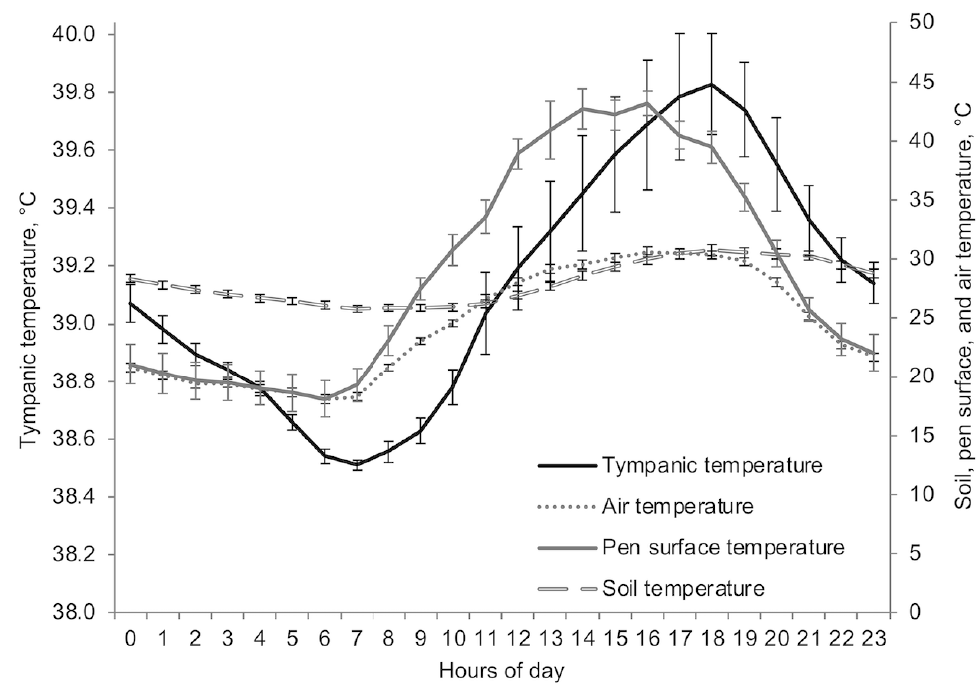
Figure 3. The least mean squares of soil temperature (at 10.2 cm depth), pen surface temperature, air temperature, and tympanic temperature by the hour of the day (5 to 12 July 2007). The bars within each variable correspond to the respective standard error of the mean.